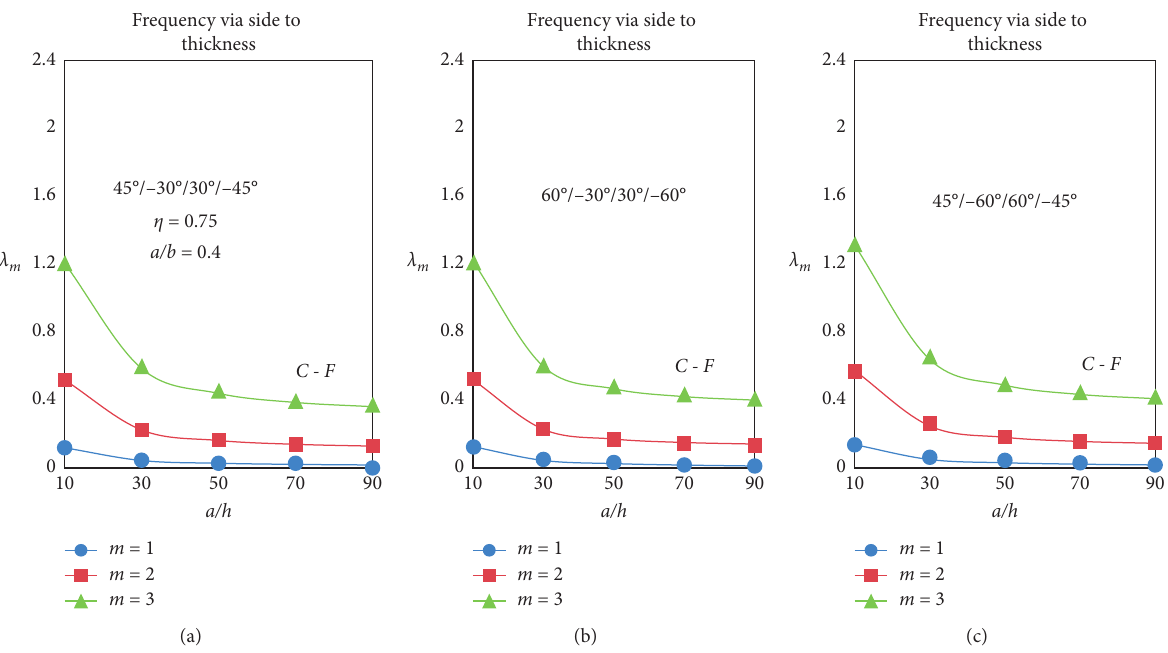
Figure 9: Influence of side-to-thickness ratio on frequency parameter value of 4-layered plates under C-F support